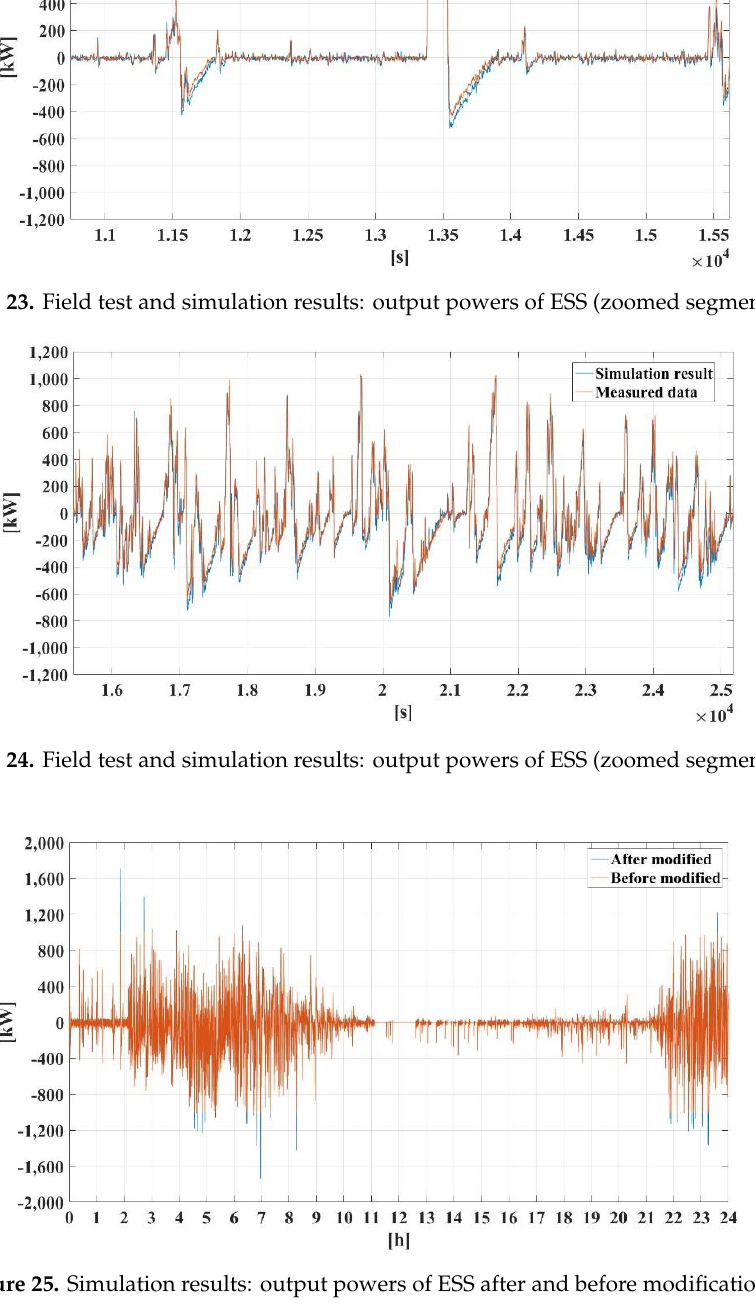
Figure 25. Simulation results: output powers of ESS after and before modification.